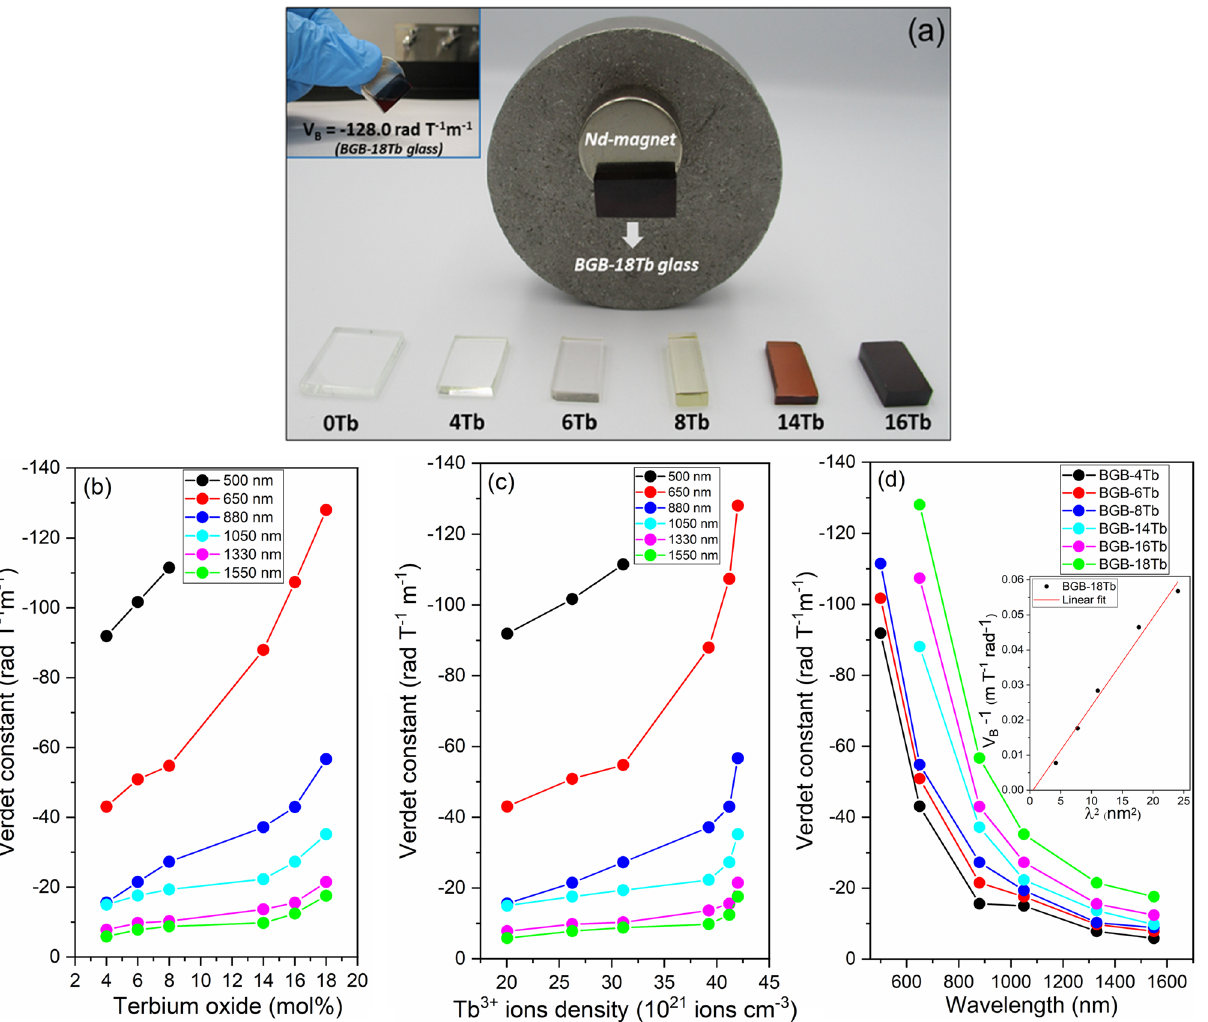
Figure 8. ( a ) Photographs of the BGB- x Tb glasses and the magnetic attraction of the BGB-18Tb glass using a commercial neodymium magnet. Plots of V B as a function of ( b ) Tb 4 O 7 content (mol%), ( c ) Tb 3+ ions density (g cm −3 ), and ( d )